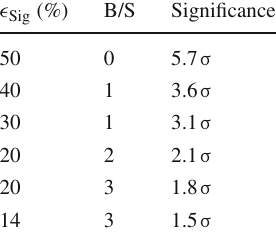
Table 7 Significance for